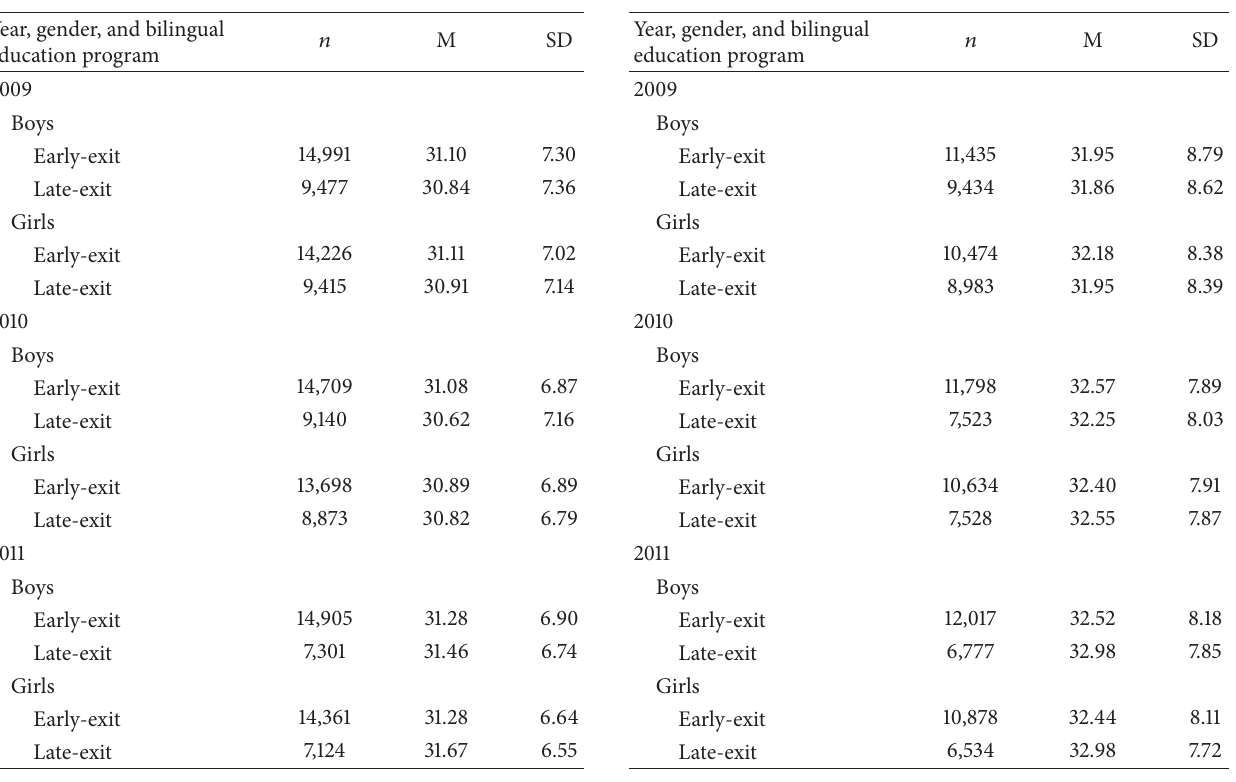
Table 5: Descriptive statistics for the 2009, 2010, and 2011 TAKS MathematicsscoresforGrade3boysandgirlsbybilingualeducation program.